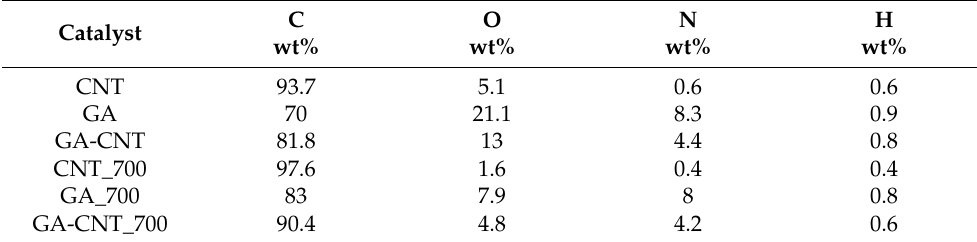
Table 1. Elemental analysis of different